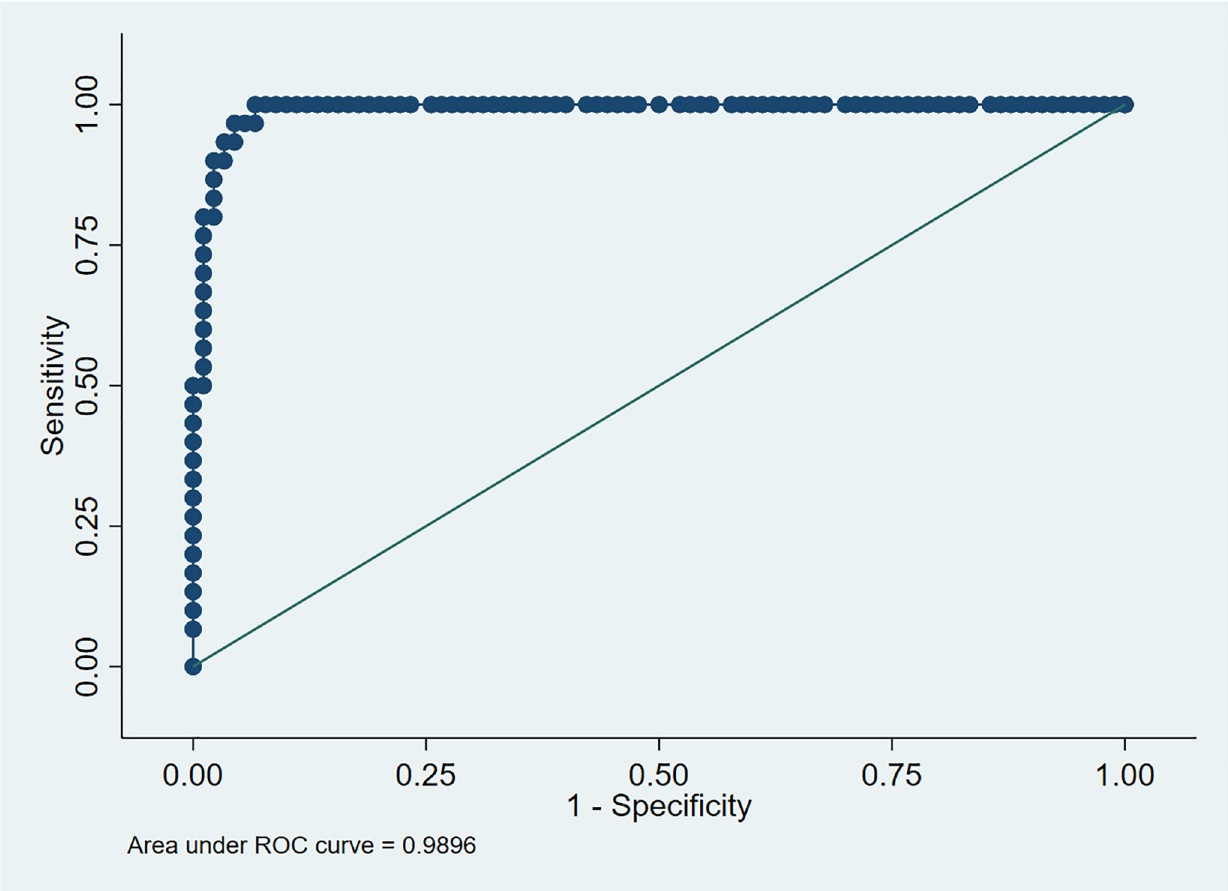
Fig 4. Performance measure for predicting Influenza A using last fitted multivariable logistic regression model.